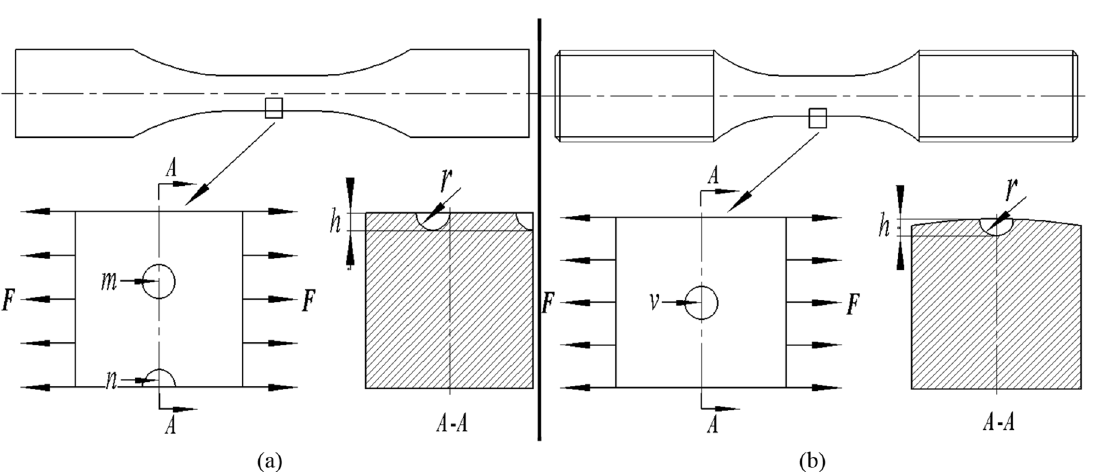
Figure 6. Sampling diagram of block element for FEM analysis: ( a ) Planar plate specimen; ( b ) Solid bar